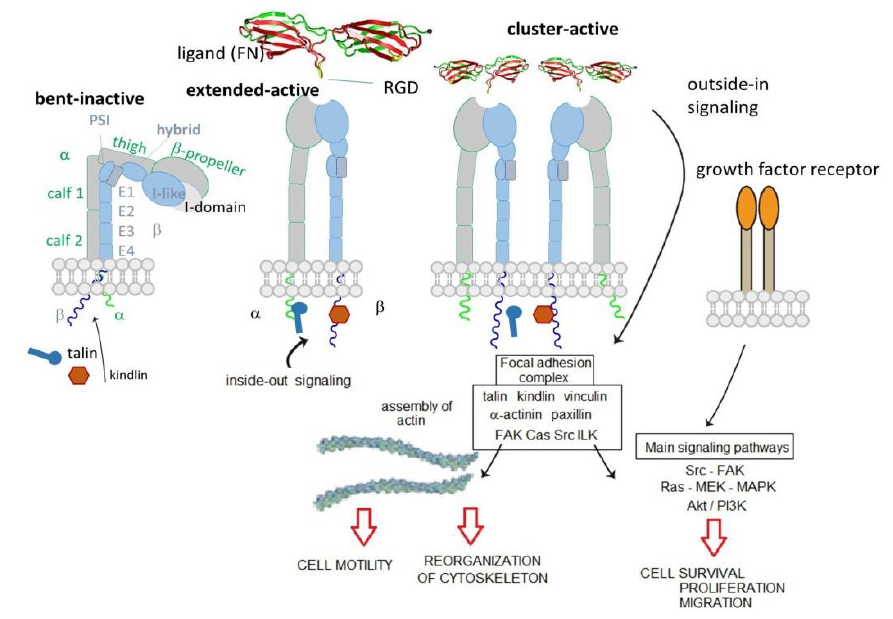
Figure 1. Bent-inactive, and open-active integrin states, and focal adhesions formation that consents outside-in downstream signaling.